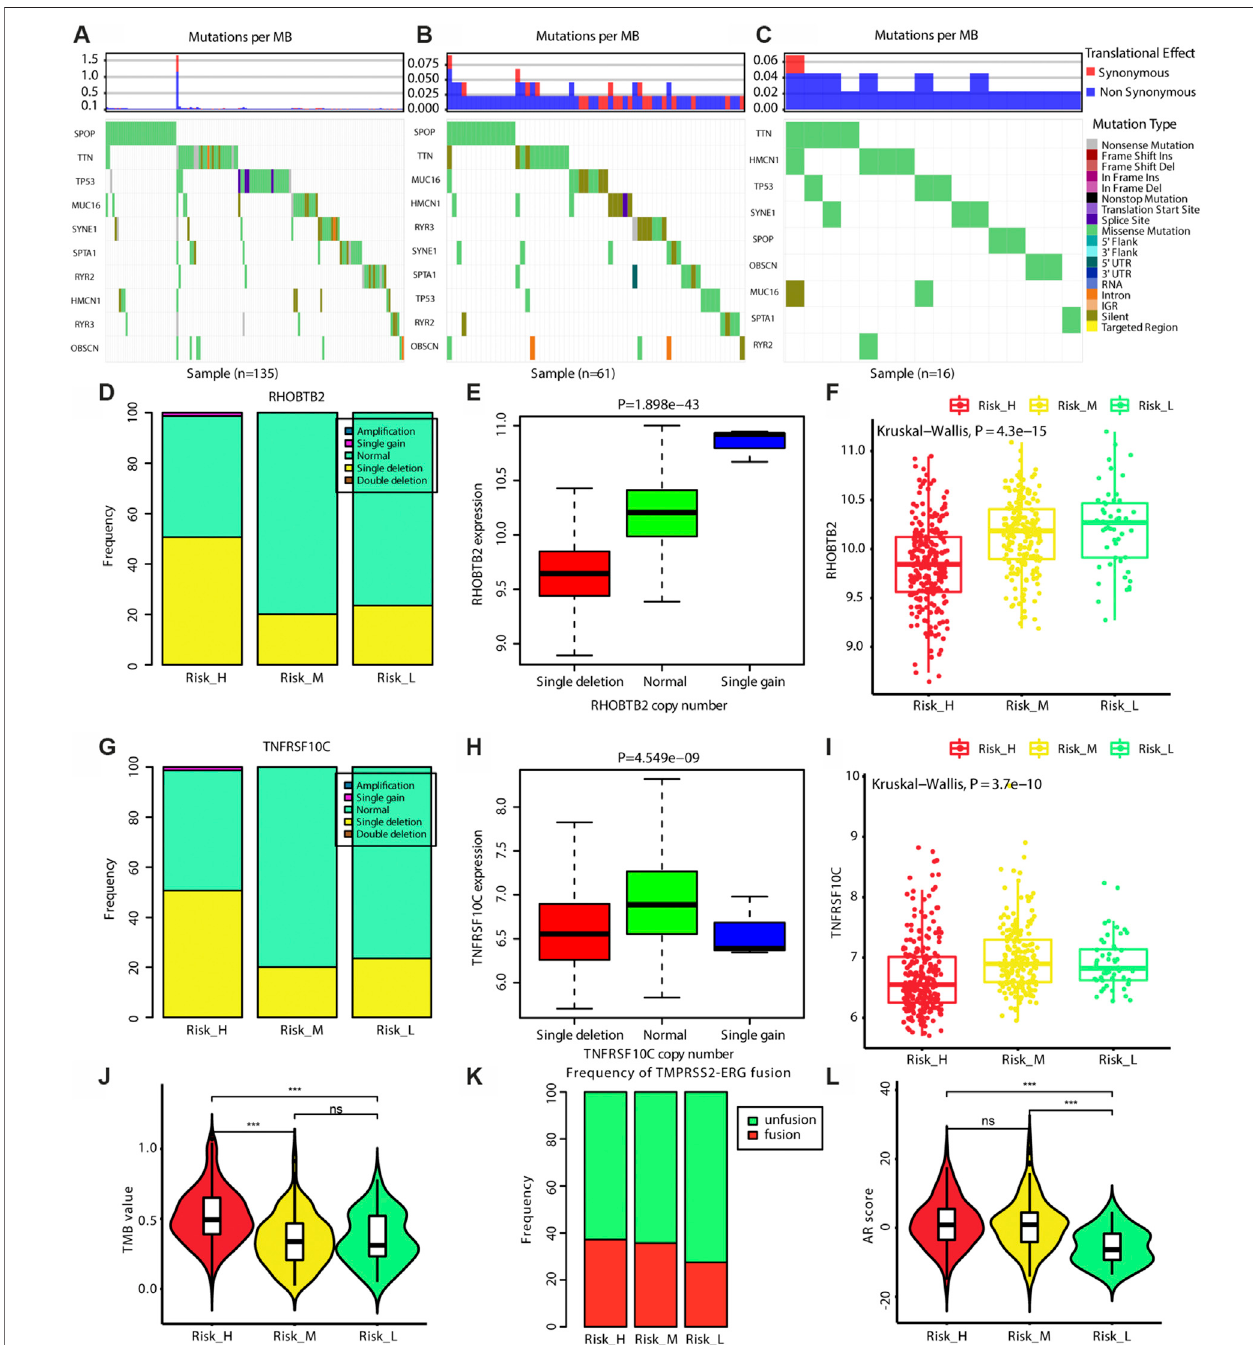
FIGURE 5| The genomic differences among three subtypes. (A) The map ofwaterfall for the Risk_H subtype. (B) The map of waterfall for the Risk_M subtype. (C) The map of waterfall for the Risk_L subtype. (D) The frequency of CNV in RHOBTB2 in Risk_H subtype is signi fi cantly higher than that in other subtype. (E) The expression level of RHOBTB2 is signi fi cantly correlated with its CNV, and the expression level of RHOBTB2 is decreased with single deletion. (F) The expression level of RHOBTB2 is the lowest in Risk_H subtype. (G) The frequency of CNV in TNFRSF10C in Risk_H subtype is signi fi cantly higher than that in other subtype. (H) The expression level of TNFRSF10C issigni fi cantlycorrelatedwithitsCNV, andtheexpression levelof TNFRSF10C isdecreasedwithsingledeletion. (I) Theexpressionlevel of TNFRSF10C is the lowest in Risk_H subtype. (J) The violin plot shows TMB values of patients are the highest in Risk_H subtype. Wilcoxon p values were calculated. (K) The bar graph shows TMPRSS2 − ERG fusion status among three subtypes. (L) The violin plot shows AR scores of patients are the higher in Risk_H and Risk_M subtypes. Wilcoxon p values were calculated. (PCa, prostate cancer; CNV, copy number variation; AR, androgen receptor. And p < 0.05 is de fi ned as statistically signi fi